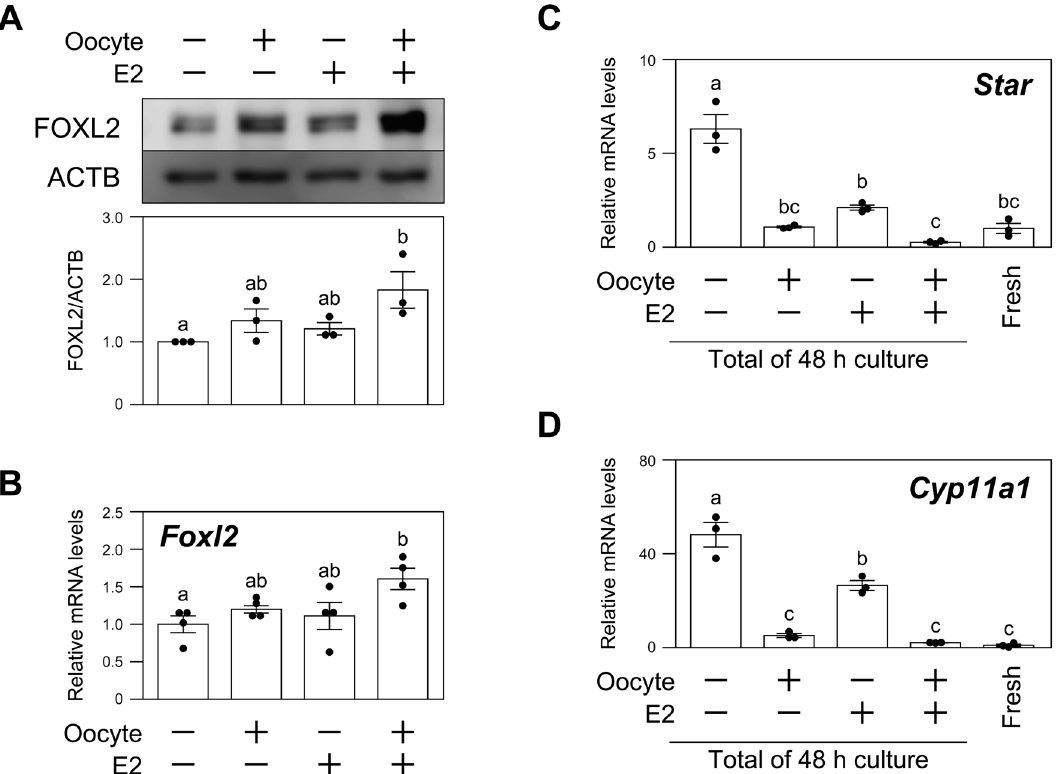
Figure 3. Effects of oocyte-derived signals and 17β-estradiol on the expression of FOXL2 in MGCs in vitro. MGCs were cultured with or without oocytes (2 oocytes/μl) and/or 17β-estradiol (E2) for 24 h. ( A ) The expression levels of FOXL2 protein were examined by western blotting (upper panel). The relative intensities of protein bands were quantified (lower panel) (n = 3). ( B ) The expression levels of Foxl2 mRNA were examined by qPCR (n = 4). The expression levels of ( C ) Star and ( D ) Cyp11a1 mRNAs were examined by qPCR (n = 3). Different letters (a, b and c) denote significant differences ( p <